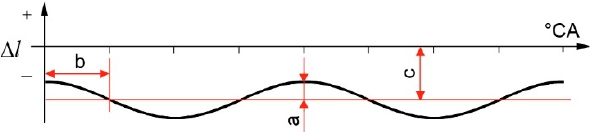
Figure 7. Model of the unilaterally fixed crankshaft. Measures of the crankshaft alignment symptom: a—amplitude, b—phase shift in relation to TDC of first crank, c—mean value.